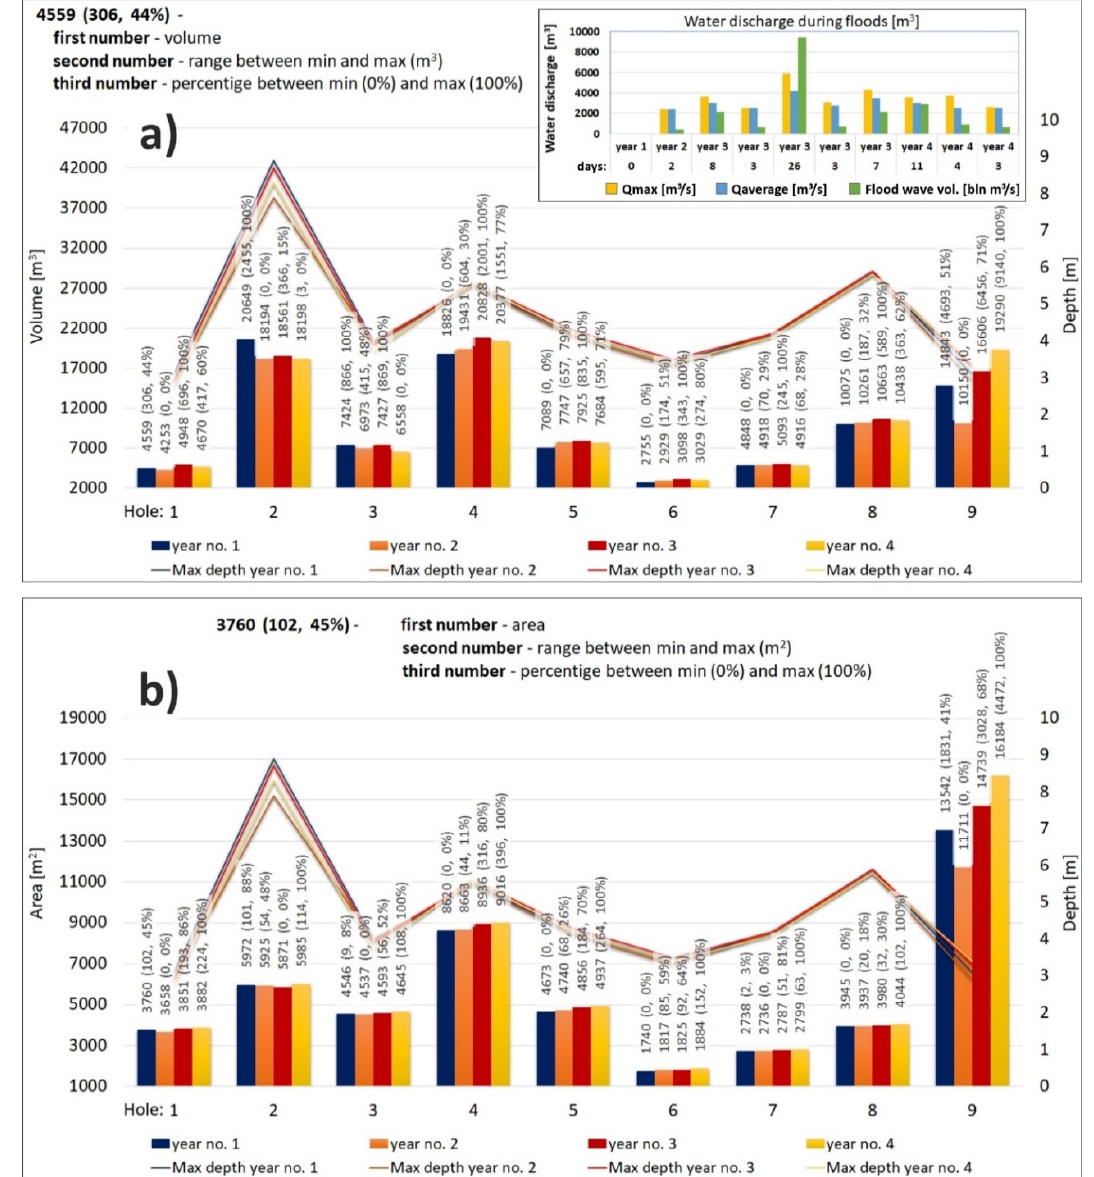
Figure 9. Graph of pothole quantification ( a ) volume (m 3 ), ( b ) area (m 2 ).